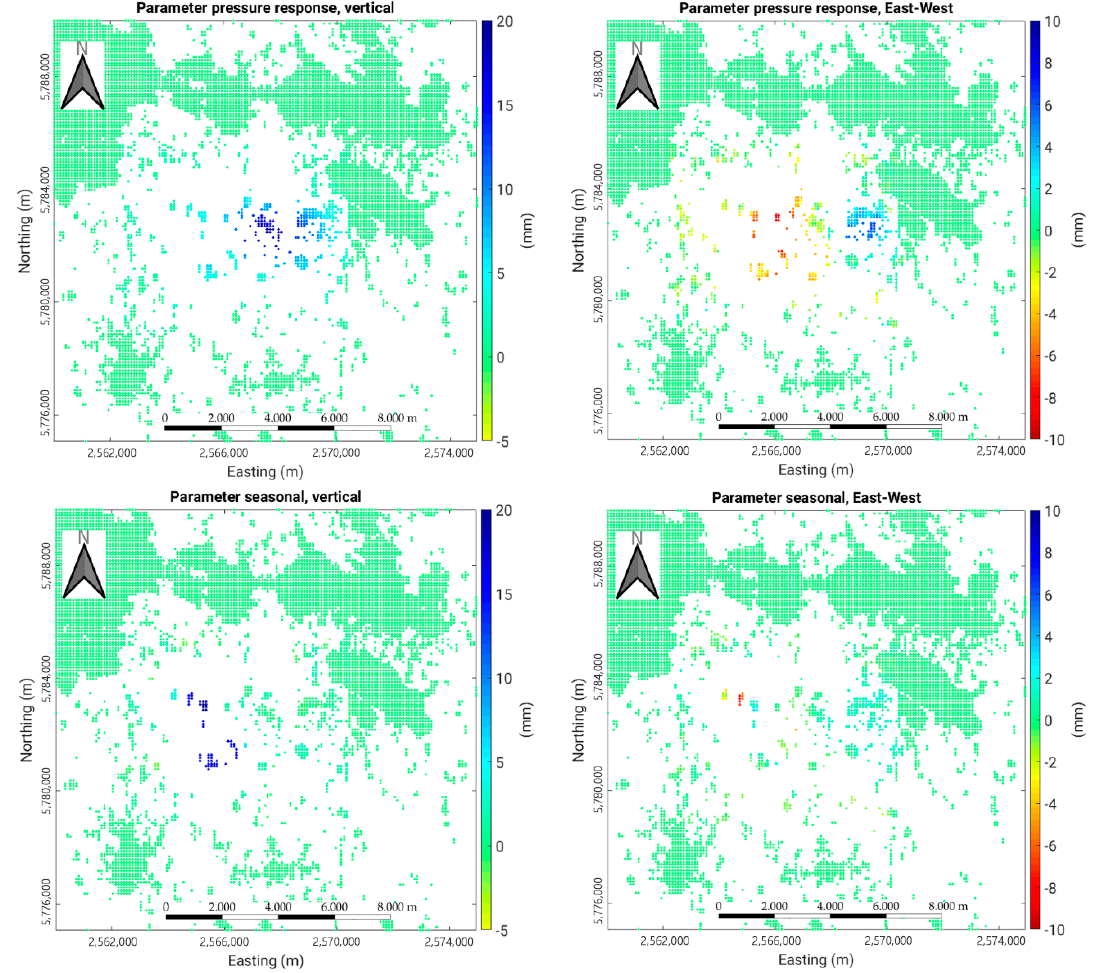
Figure 14. Parameters for pressure response and seasonal displacement transformed to vertical and east-west direction from geometric orbit combination.